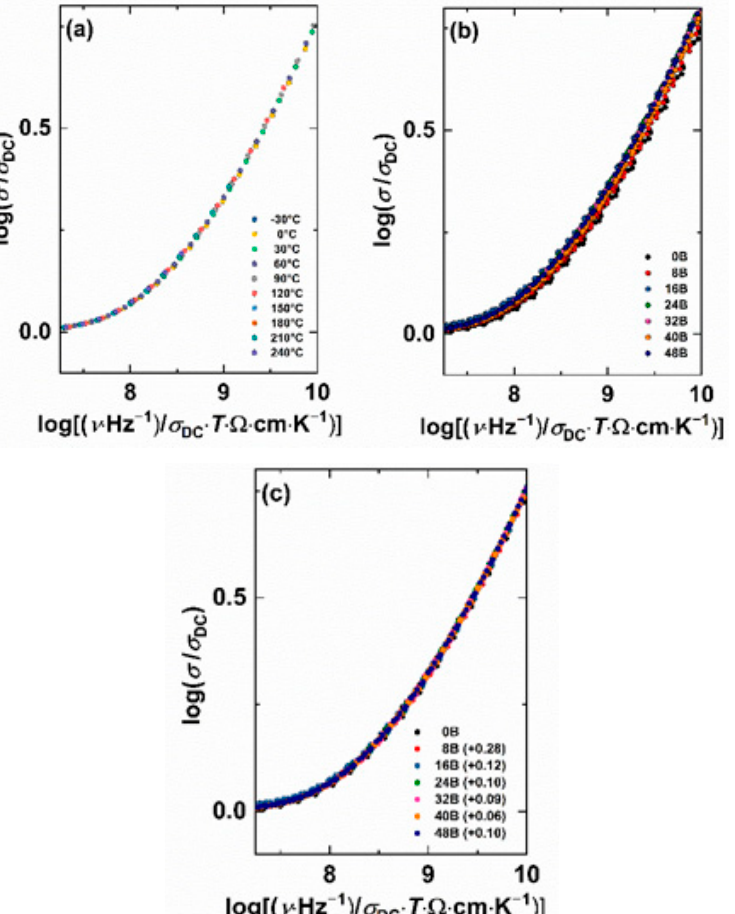
Figure 10. ( a ) Summerfield master curve for glass 8 mol% B 2 O 3 , ( b ) Construction of super master-curve of the conductivity isotherms using Summerfield scaling procedure for studied glass series, ( c ) individual master-curves of all glasses shifted along the x-axis to overlap with the reference master-curve of 0B glass.